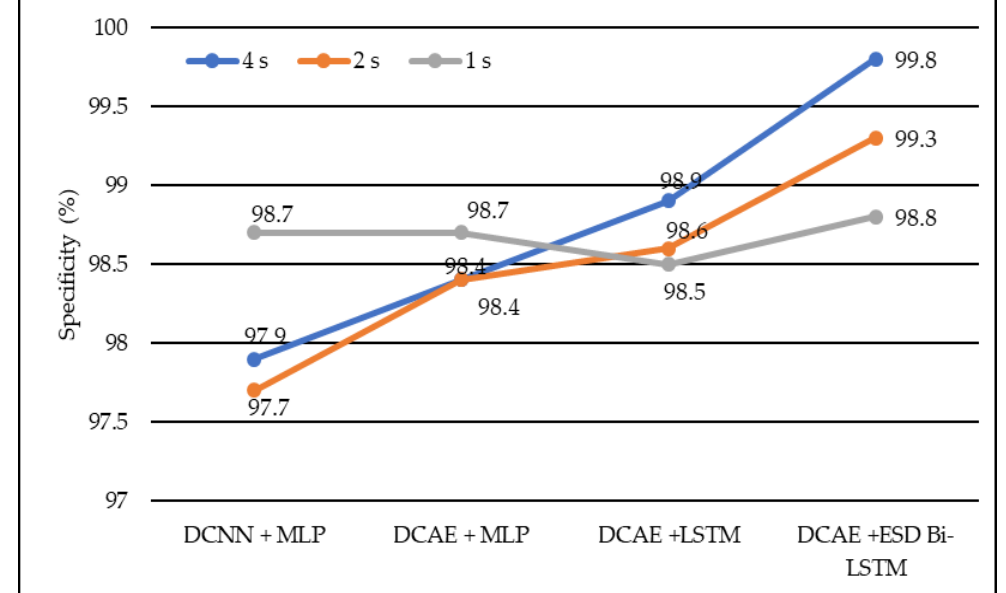
Figure 7. Average specificity of different models using different EEG segment lengths.